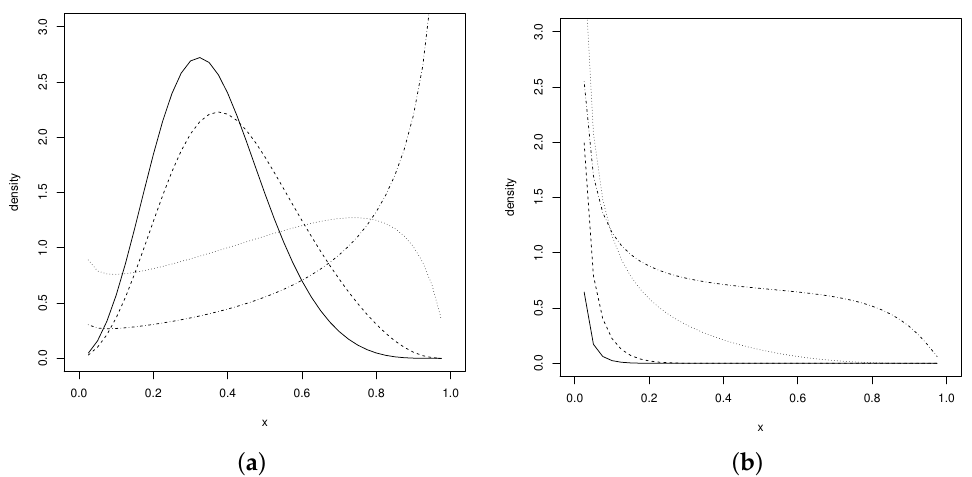
Figure 1. UPSN distribution for µ = 0.25 and σ = 1.75 ( a ) values of ( λ , α ) = ( − 1.75,0.5 ) (dotted–dashed line), ( − 1.75,1.5 ) (dotted line), ( − 4.75,3.5 ) (dashed line) and ( − 4.75,5.5 ) (solid line), ( b ) values of ( λ , α ) = ( 1.75,0.5 ) (dotted–dashed line), ( 1.75,1.5 ) (dotted line), ( 4.75,3.5 ) (dashed line) and ( 4.75,5.5 ) (solid line).